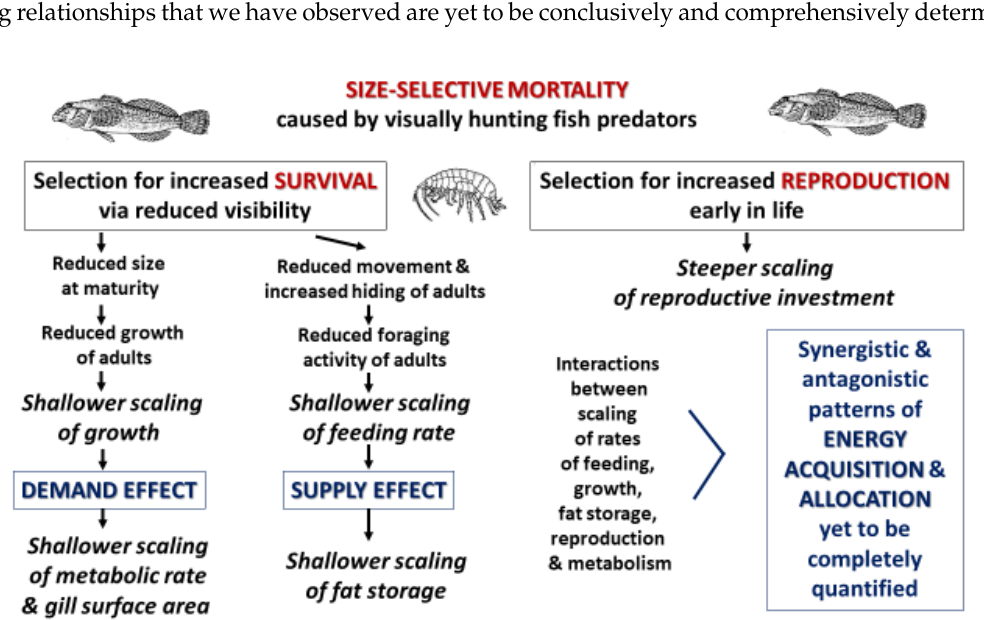
Figure 9. Flow diagram depicting hypothetical mechanisms underlying effects of size-selective predation by visually hunting fish on the ontogenetic body-mass scaling of various energetically significant traits related to somatic and reproductive investment in the freshwater amphipod Gammarus minus . This diagram features adaptive evolutionary responses to size-specific selection for increased adult survival via reduced visibility and increased reproduction early in life. Interactions among the various scaling relationships for energy intake and expenditure have yet to be fully quantified and understood.